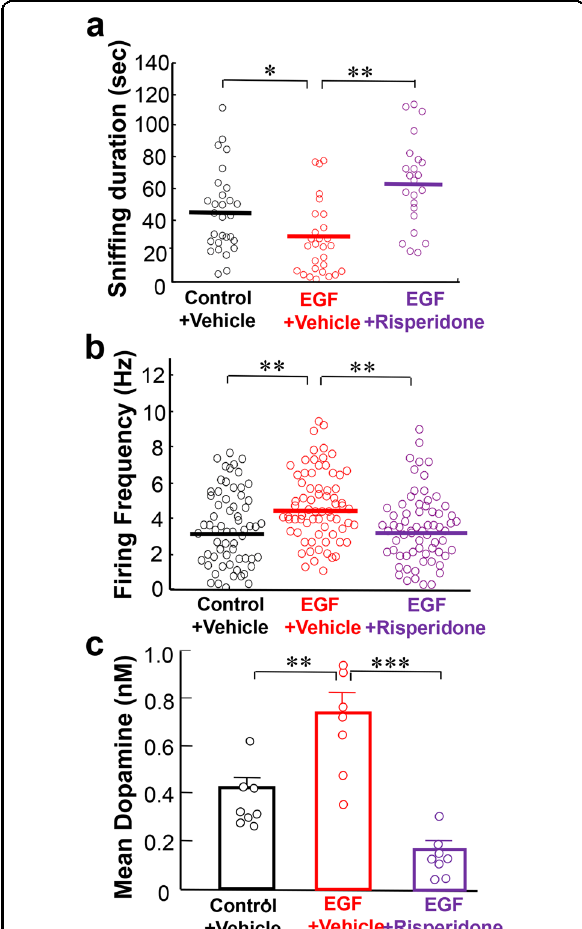
Fig. 3 Subchronic antipsychotic actions on social interaction scores, fi ring activities, and basal dopamine release of epidermal growth factor model rats. a Snif fi ng durations of EGF model rats ( n = 23) which had subchronically received risperidone (1.0 mg/kg/ day, i.p.) were compared with those of EGF model rats ( n = 28)